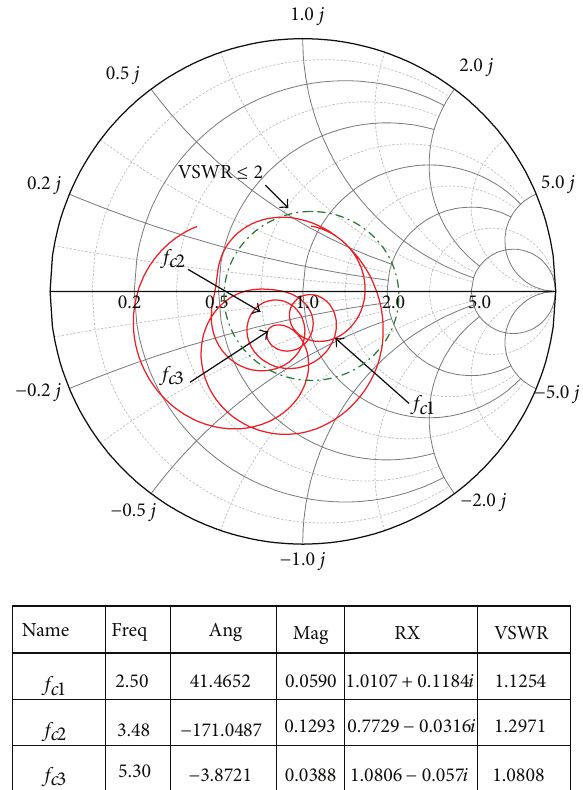
Figure 2: Smith chart of the proposed